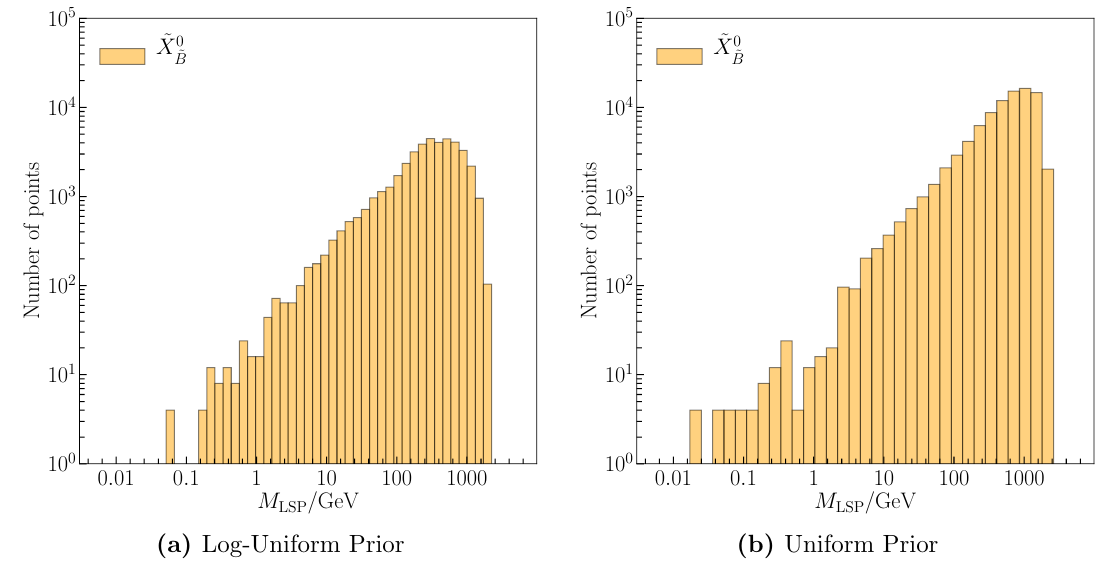
Figure 18. Distributions of the Bino neutralino LSP masses for the valid black points, shown for (a) log-uniform prior and (b) uniform prior. The mass ranges for the Bino LSPs are similar for both prior